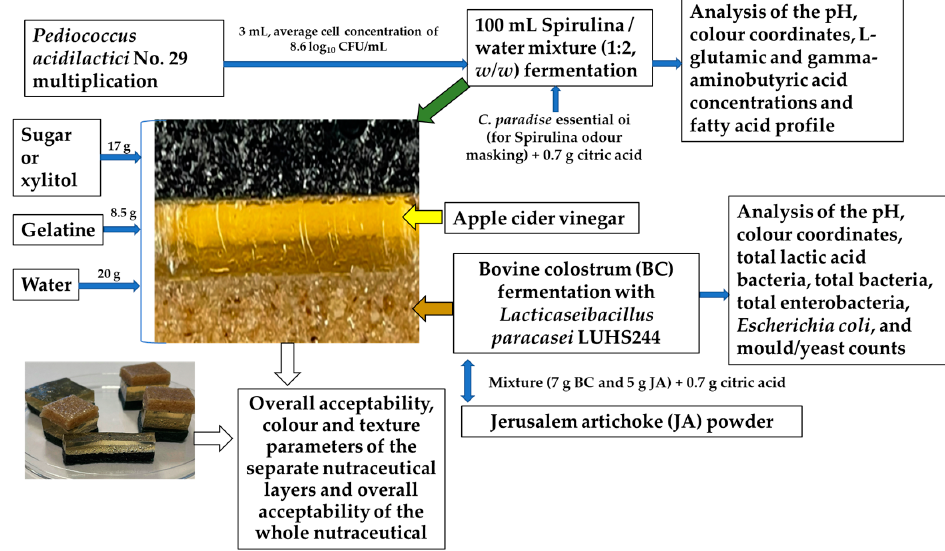
Figure 1. Principal scheme of the